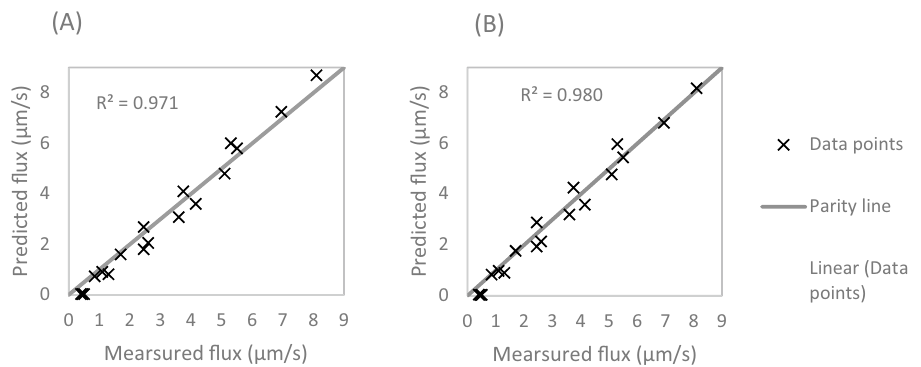
Figure 3. Parity line of simulated flux plotted against the measured flux values, from Table 3. ( A ) Model constants are determined from Sherwood number. ( B ) Model constants are determined from RMS fitting to the experimental data.